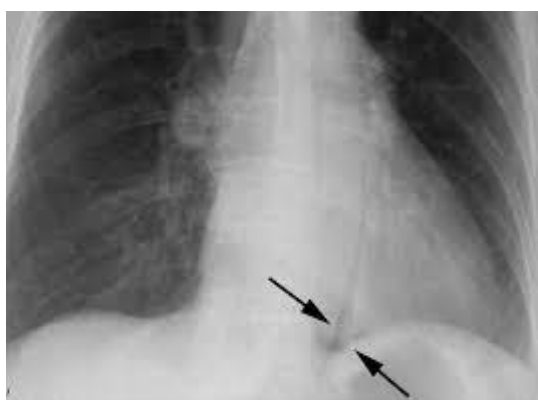
Figure 1. The Naclerio’s V sign seen on the frontal radiographs of the chest as a V-shaped air lucency in the left lower mediastinal segment Esophagography Esophagography is an imaging technique